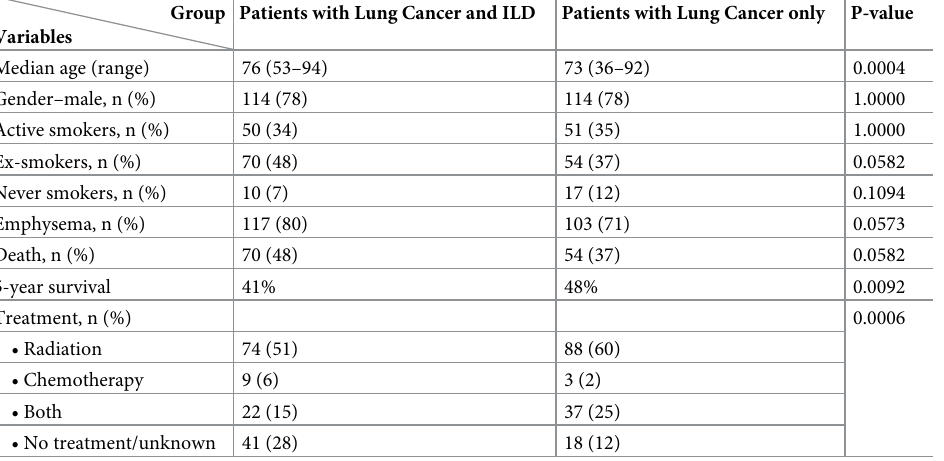
Table 1. Patients’ characteristics.